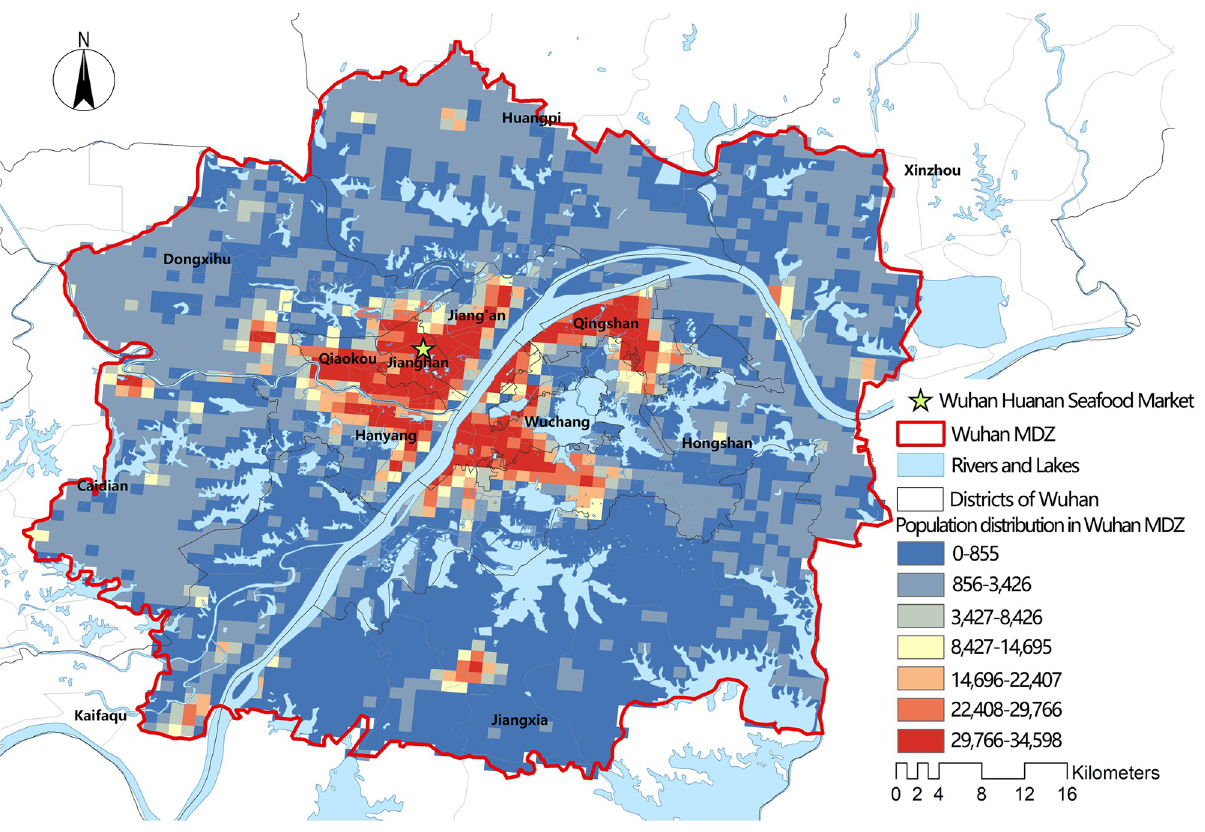
Fig 4. Population distribution of the Wuhan MDZ for every km 2